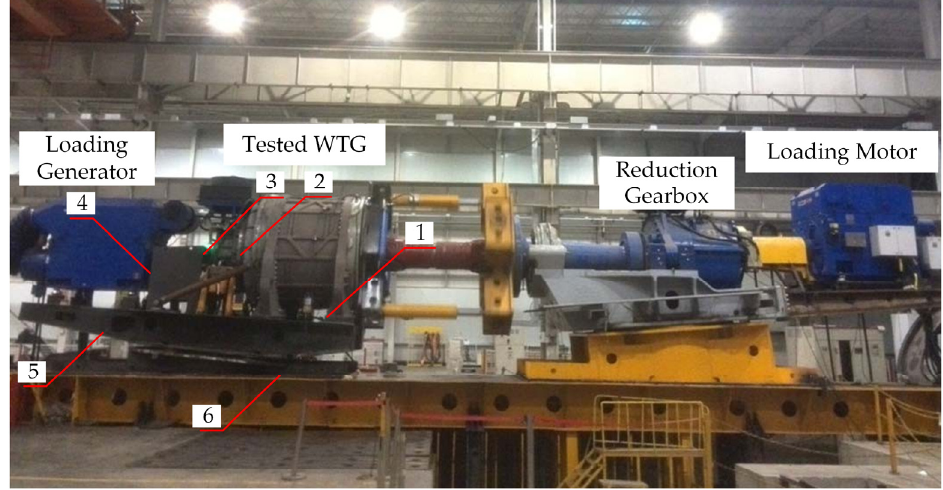
Figure 8. Full test rig and sensor arrangement.